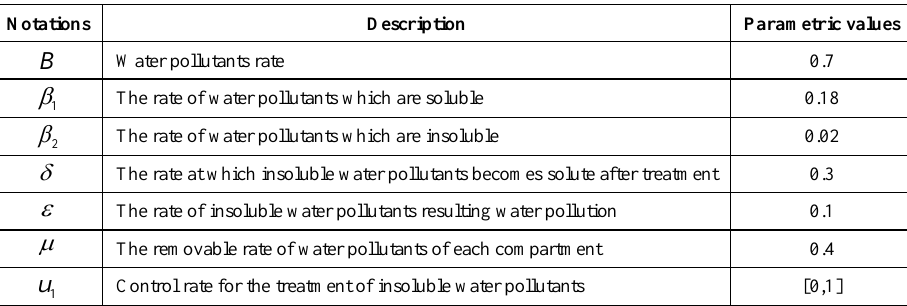
Table 1. Notations and its parametric values